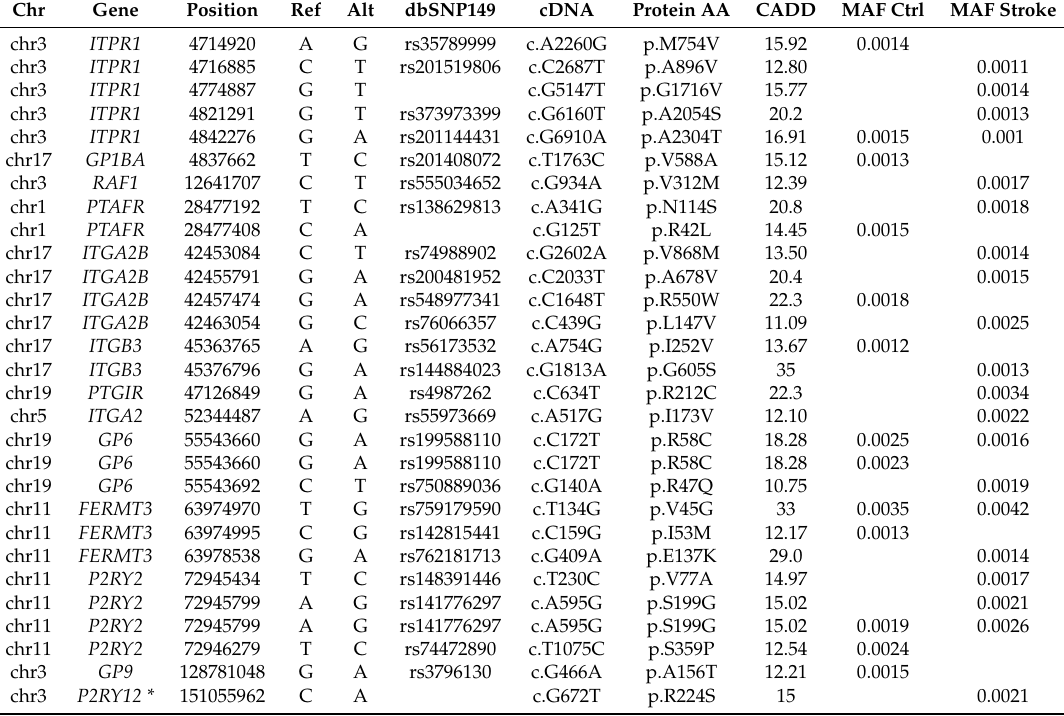
Table 1. List of all rare (predicted MAF < 0.1%) non-synonymous and deleterious single nucleotide variants observed in the investigated Polish patients ( n = 1000) after pooled resequencing of exons in 26